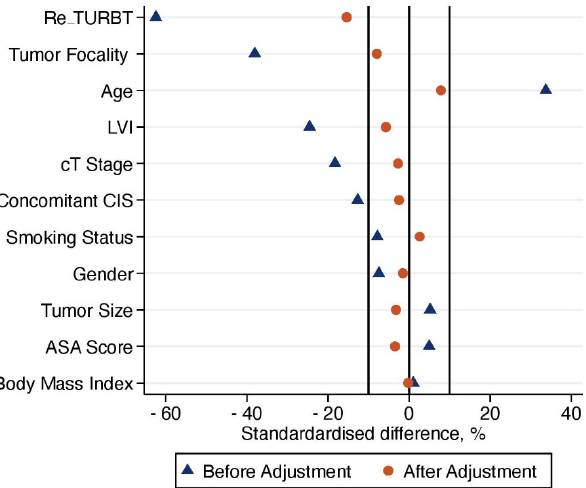
Figure 4. Impact inverse probability of treatment weighting (IPTW) adjustment on the distribution of baseline characteristics of included patients treated with upfront or delayed eRC for HR-NMIBC.